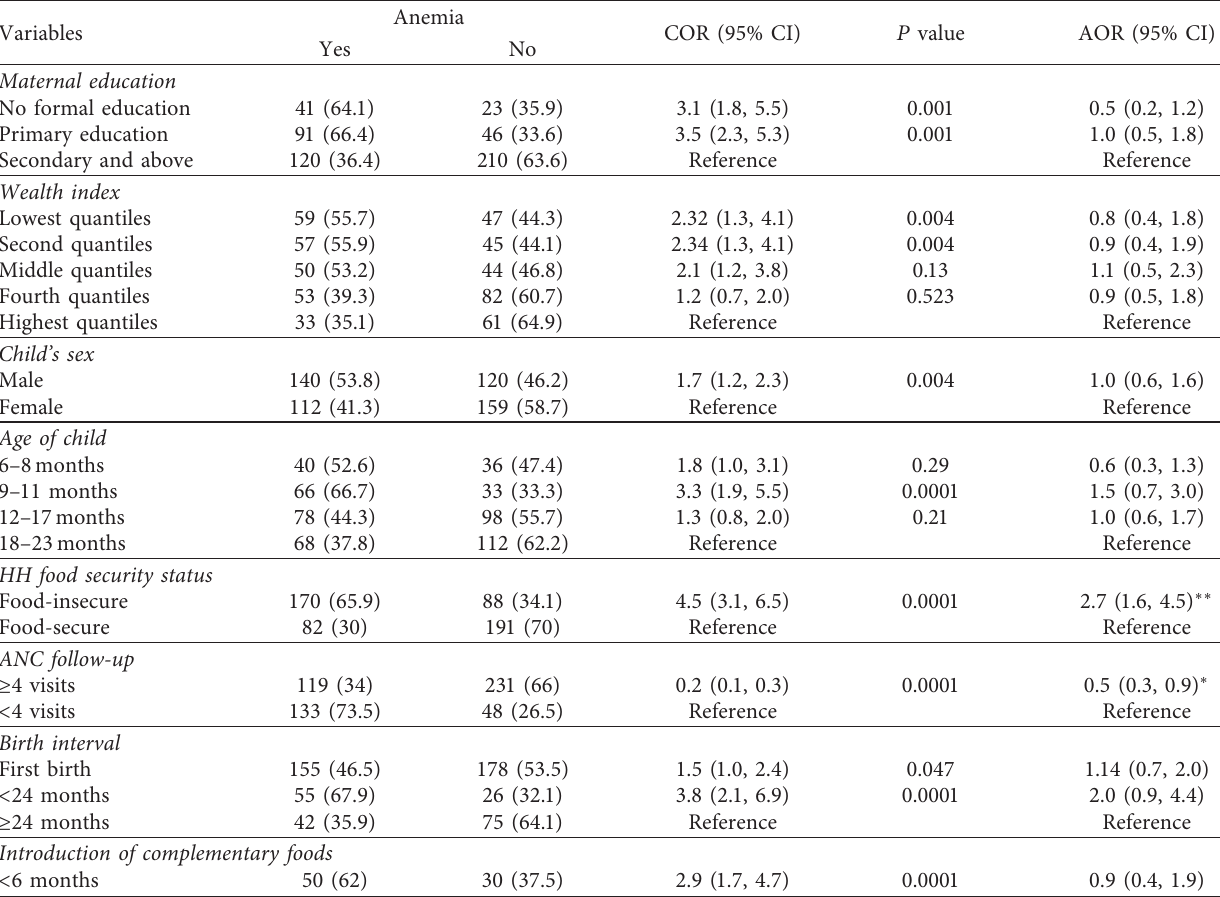
Table 5: Factors associated with anemia among infant and young children aged 6–23 months in Debre Berhan Town, Ethiopia, 2018 ( n �